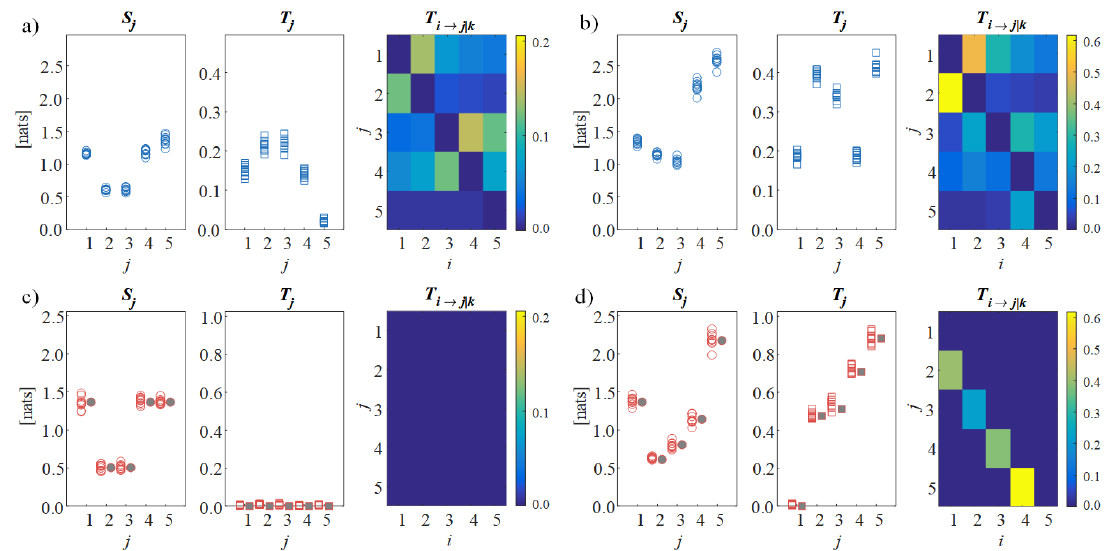
Figure 2. Estimation of information dynamics for the simulated scenarios. Plots depict the distributions across 10 trials of the information storage ( S j , circles) and the total information transfer ( T j , squares), as well as the color-coded median values of the conditional information transfer ( T i , j → k , connectivity matrices) computed for the simulated scalp signals ( a , b ) and for the cortical sources reconstructed using the proposed approach ( c , d ) in the first condition of absence of connectivity ( a , c ) and in the second condition with unidirectional source propagation ( b , d ). The filled symbols in ( c , d ) indicate the exact values of the information stored in each cortical source and the total information transferred to